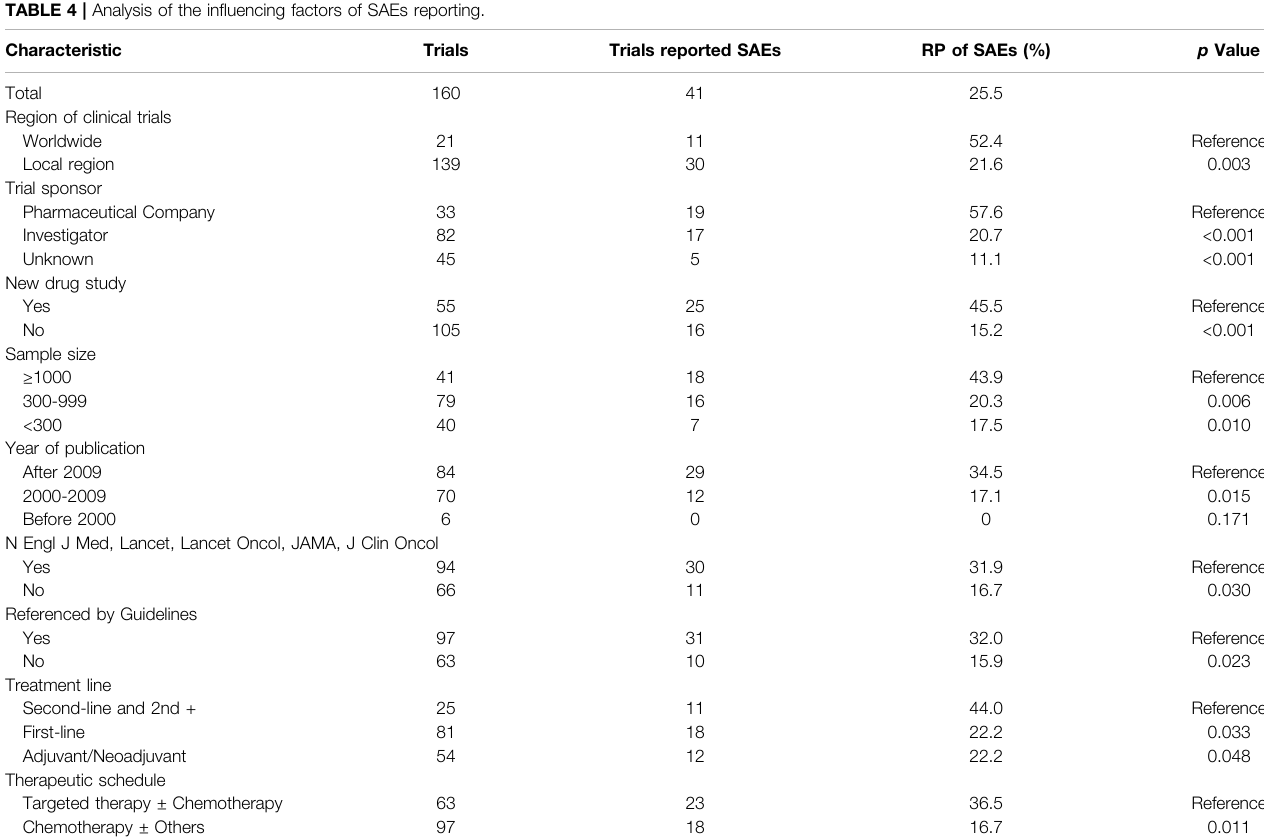
TABLE 4 | Analysis of the in fl uencing factors of SAEs